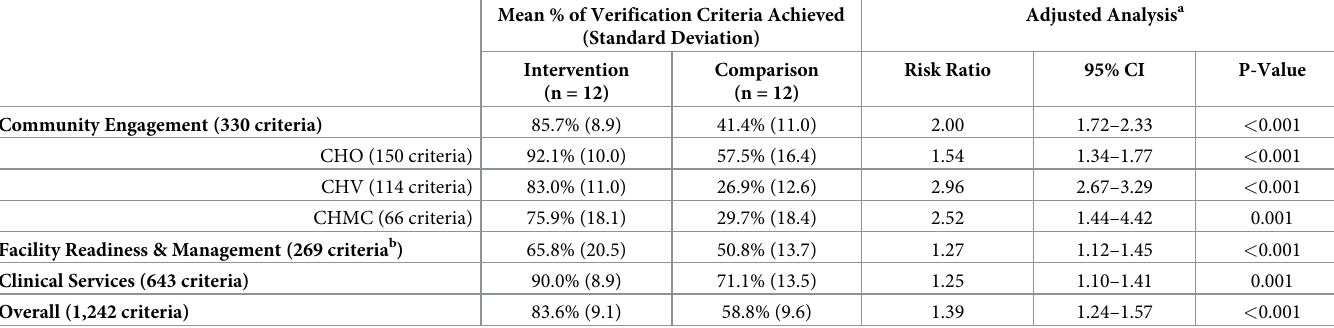
Table 3. SBM-R assessment: percentage of verification criteria achieved by category and study